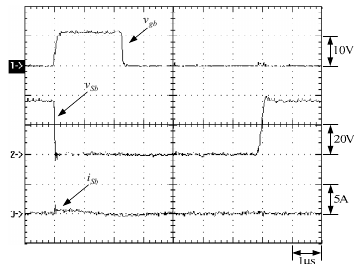
Figure 21. Waveforms pertaining to S a at the minimum load: (1) v ga ; (2) v Sa ; and (3) i Sa .